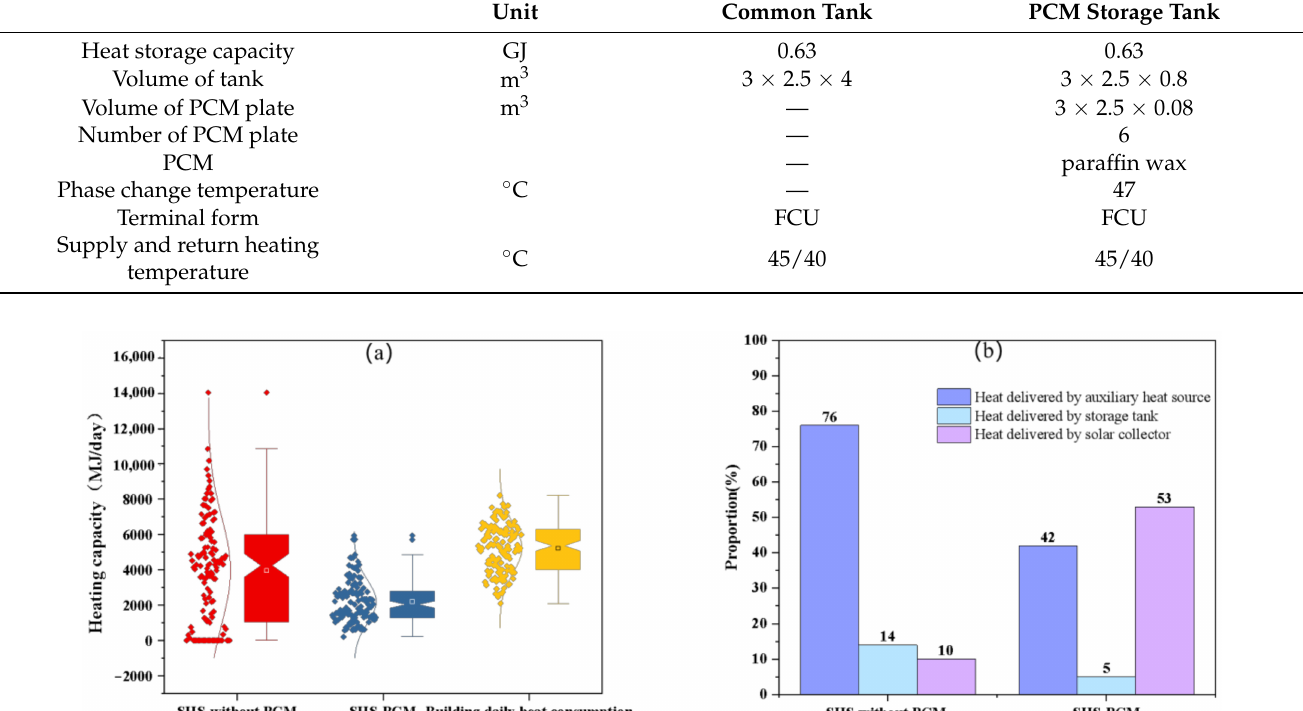
Table 3. Design parameters for common tank and PCM storage tank.